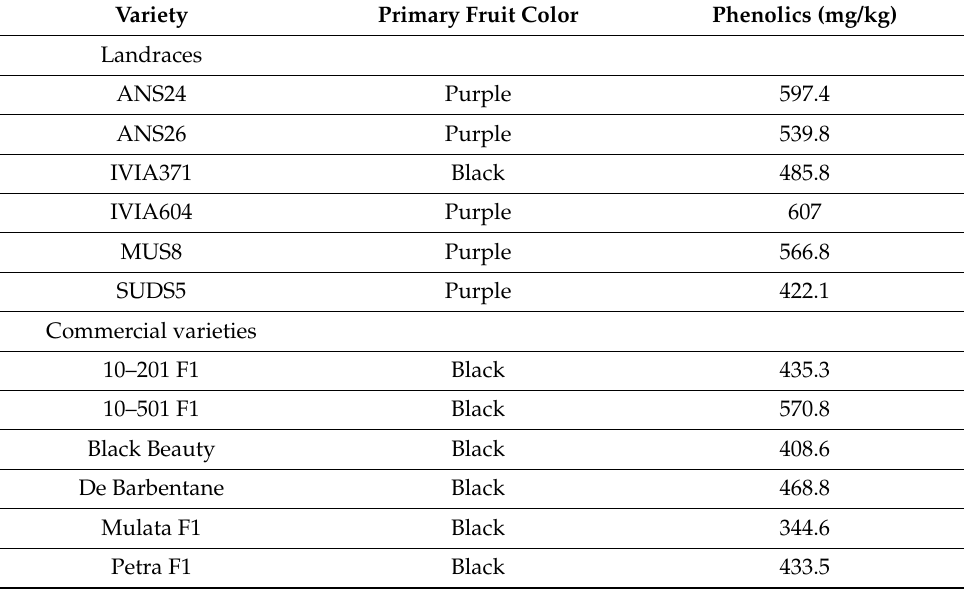
Table 9. Variations in phenolic content in mg/kg in different eggplant cultivars